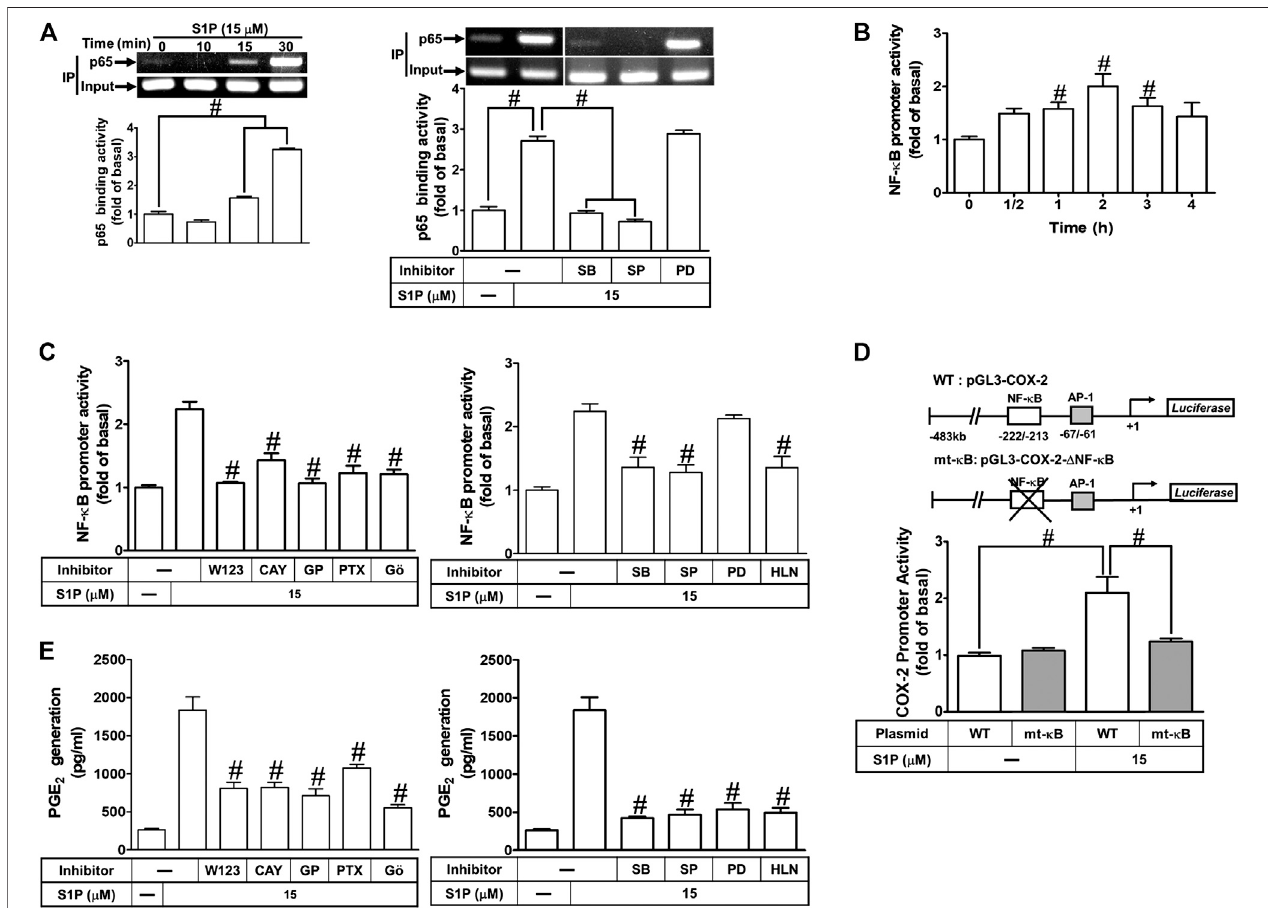
FIGURE9| COX-2promoteractivityisstimulatedbyS1PthroughanNF- κ B-dependentpathway. (A) CellswereincubatedwithS1Pfortheindicatedtimeintervals (upperpanel). Cells werepretreatedwith PD98059(10 μ M),SB202190 (30 μ M), SP600125 (10 μ M) for1 h and then incubated withS1P for30 min. Thebinding activity ofNF- κ Bp65andpromoterwasanalyzedbyChIPassay(n (cid:2) 3),asdescribedin Methods .Leftpanel,to fi ttheconstructofdatalayout,thedatawererearrangedfromthe same gel with the exception of non-related inhibitors and disclosed by the insertion of white spaces rearranged from the original capture. (B,C) Cells were transfectedwithanNF- κ B-luciferasereportergene,pretreatedwithW123(10 μ M),CAY(10 μ M),GPA2A(10 μ M),PTX(100 ng/ml),Gö6976(10 μ M),PD98059(10 μ